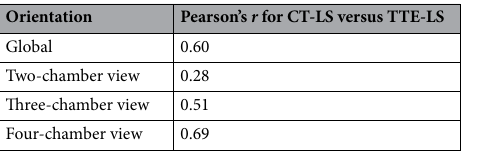
Table 3. Pearson’s correlation coefficient between CT-derived and TTE-derived longitudinal strain. LS longitudinal strain.